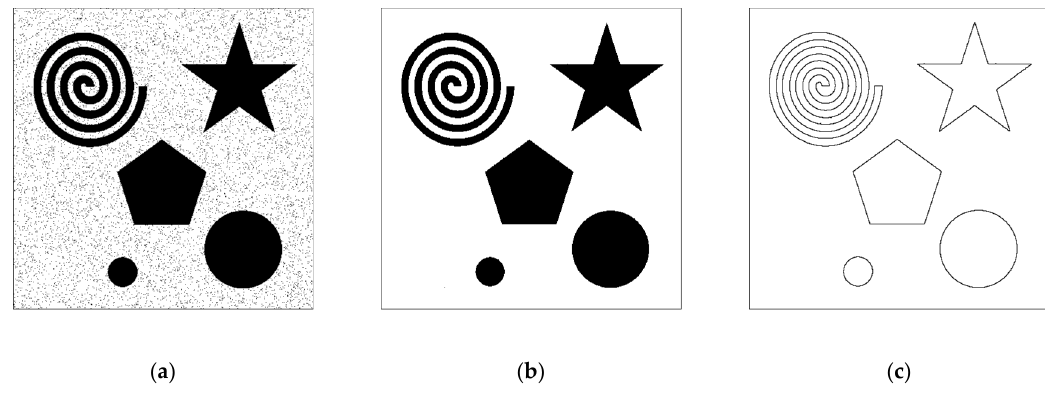
Figure 20. ( a ) The initial noisy image, ( b ) after filtering out noise, and ( c ) after finding the boundaries of the figures.